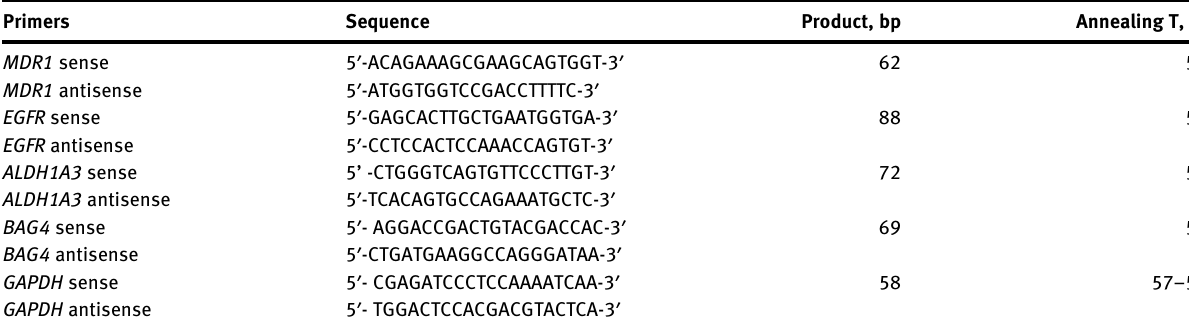
Table  : Primer sequences for RT-PCR.